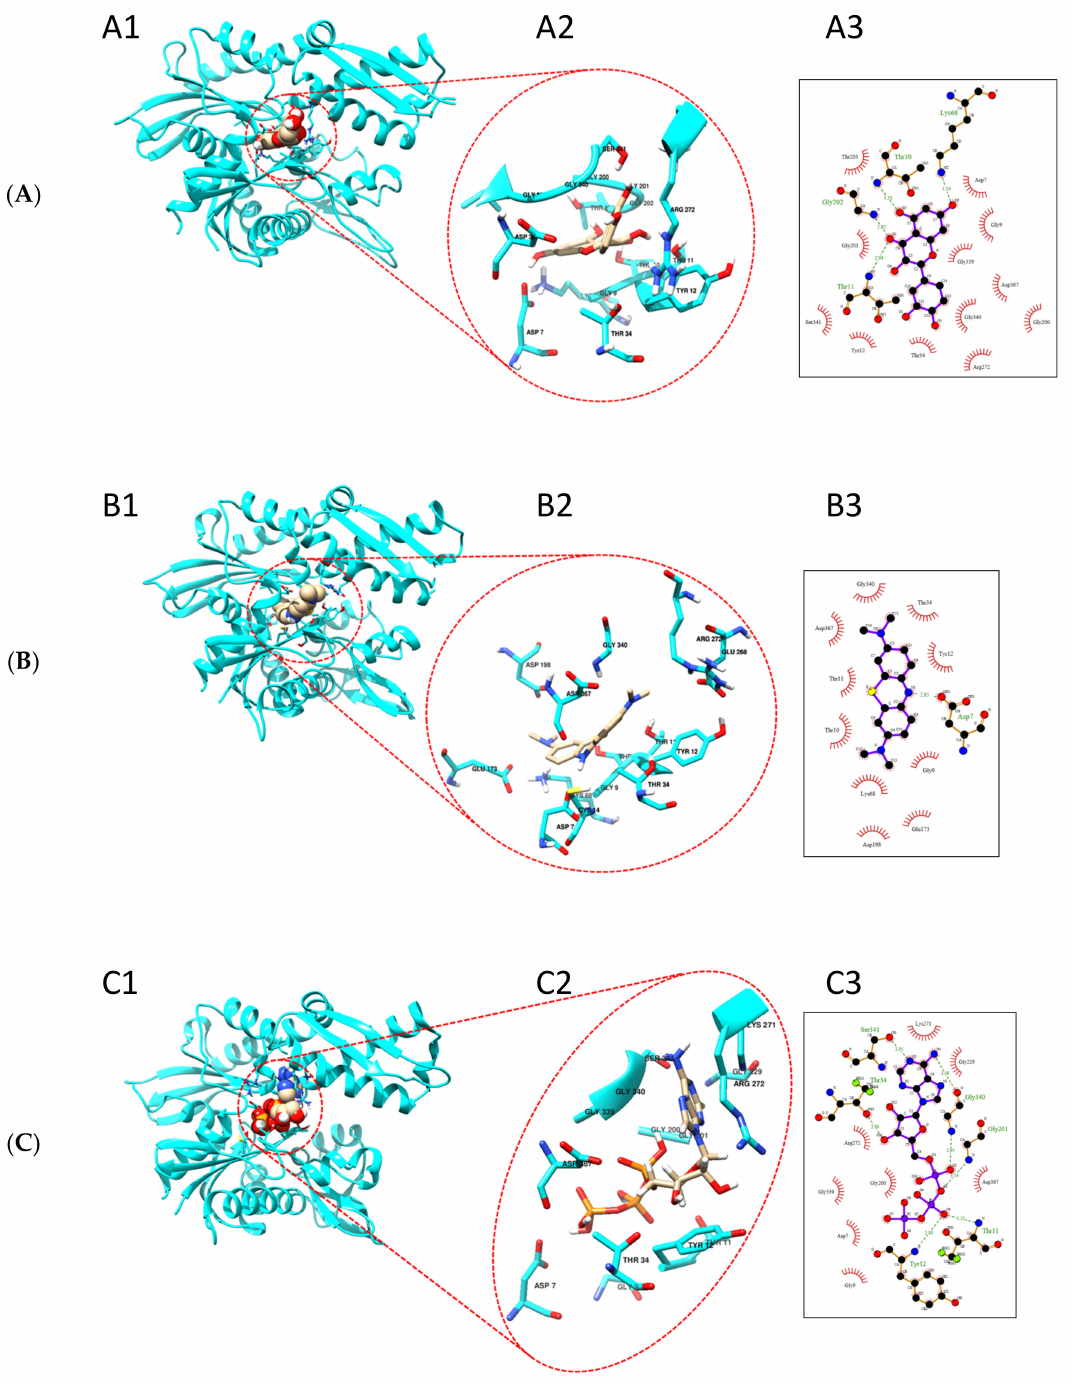
Figure 9. Putative binding sites of quercetin and methylene blue on TbHsp70.c. Homology model of the ATPase domain of TbHsp70.c showing predicted binding with ( A ) quercetin, ( B ) methylene blue, and ( C ) ATP. ( A1 – C1 ) show the ATPase domain of TbHsp70.c binding quercetin, methylene blue, and ATP, respectively; ( A2 – C2 ) show the zoomed-in image of the binding sites; ( A3 – C3 ) show the residues that form hydrogen bonds (represented by dotted lines), and residues that form hydrophobic interactions (represented by lash-resembling structures) with quercetin, methylene blue, and ATP,